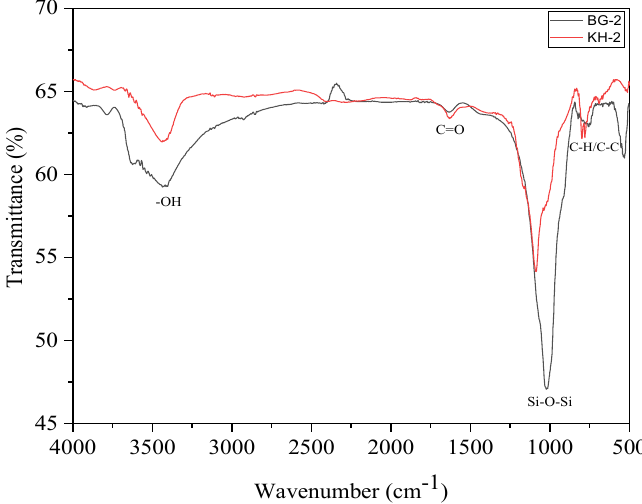
Figure 7. Fourier-Transform Infrared Spectroscopy (FTIR) Spectrum of BG-2 and KH-2 shales.